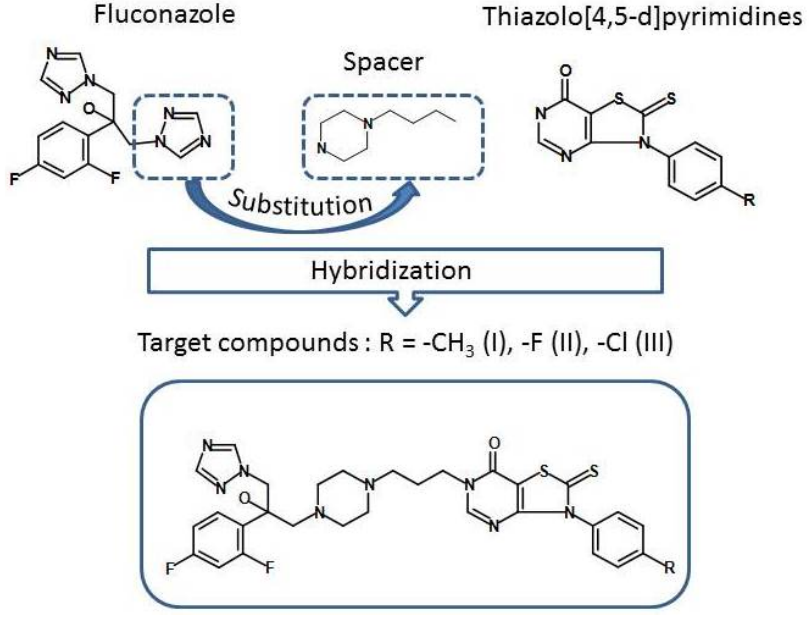
Figure 1. Design of novel target hybrids fluconazole and